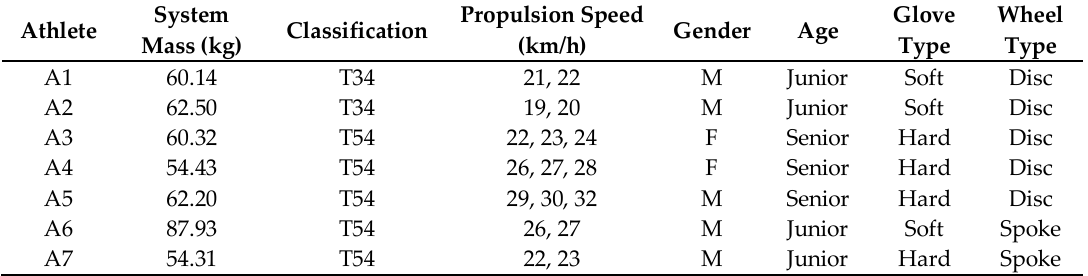
Table 1. Athlete demographics. System mass represents both athlete and wheelchair